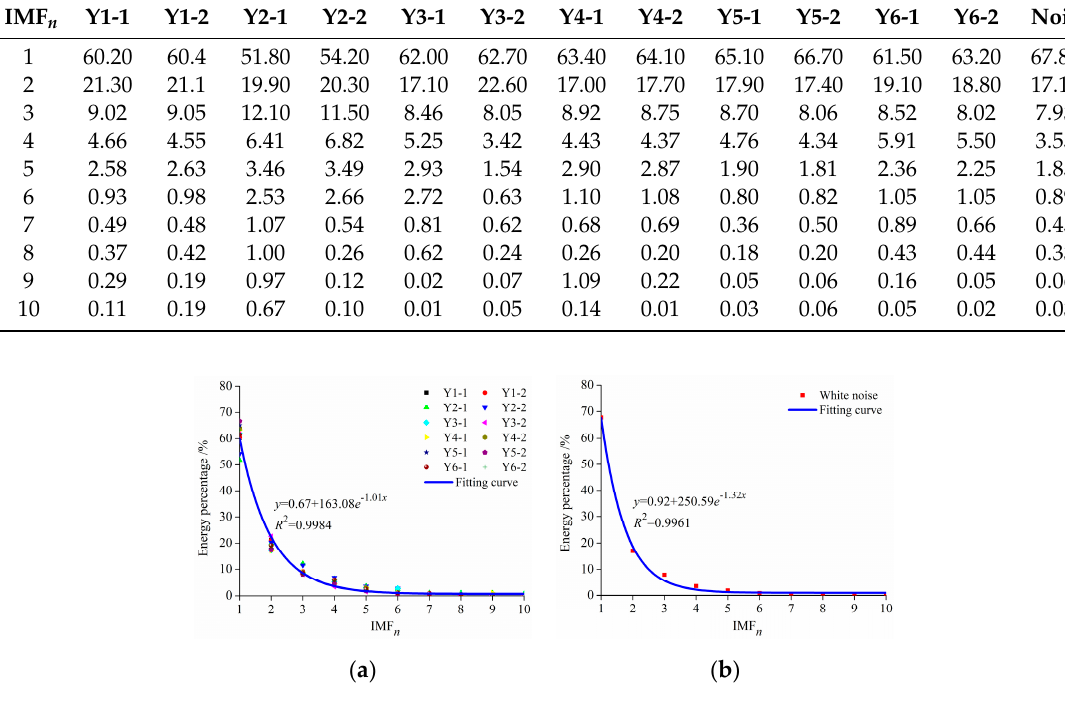
Figure 6. Contrast of the energy percentage of the signal without obvious change and noise. ( a ) Signal without an obvious change and ( b ) white noise. For the label of horizontal axis, IMF n represents respectively IMF1, IMF2, IMF3, …, IMF10.